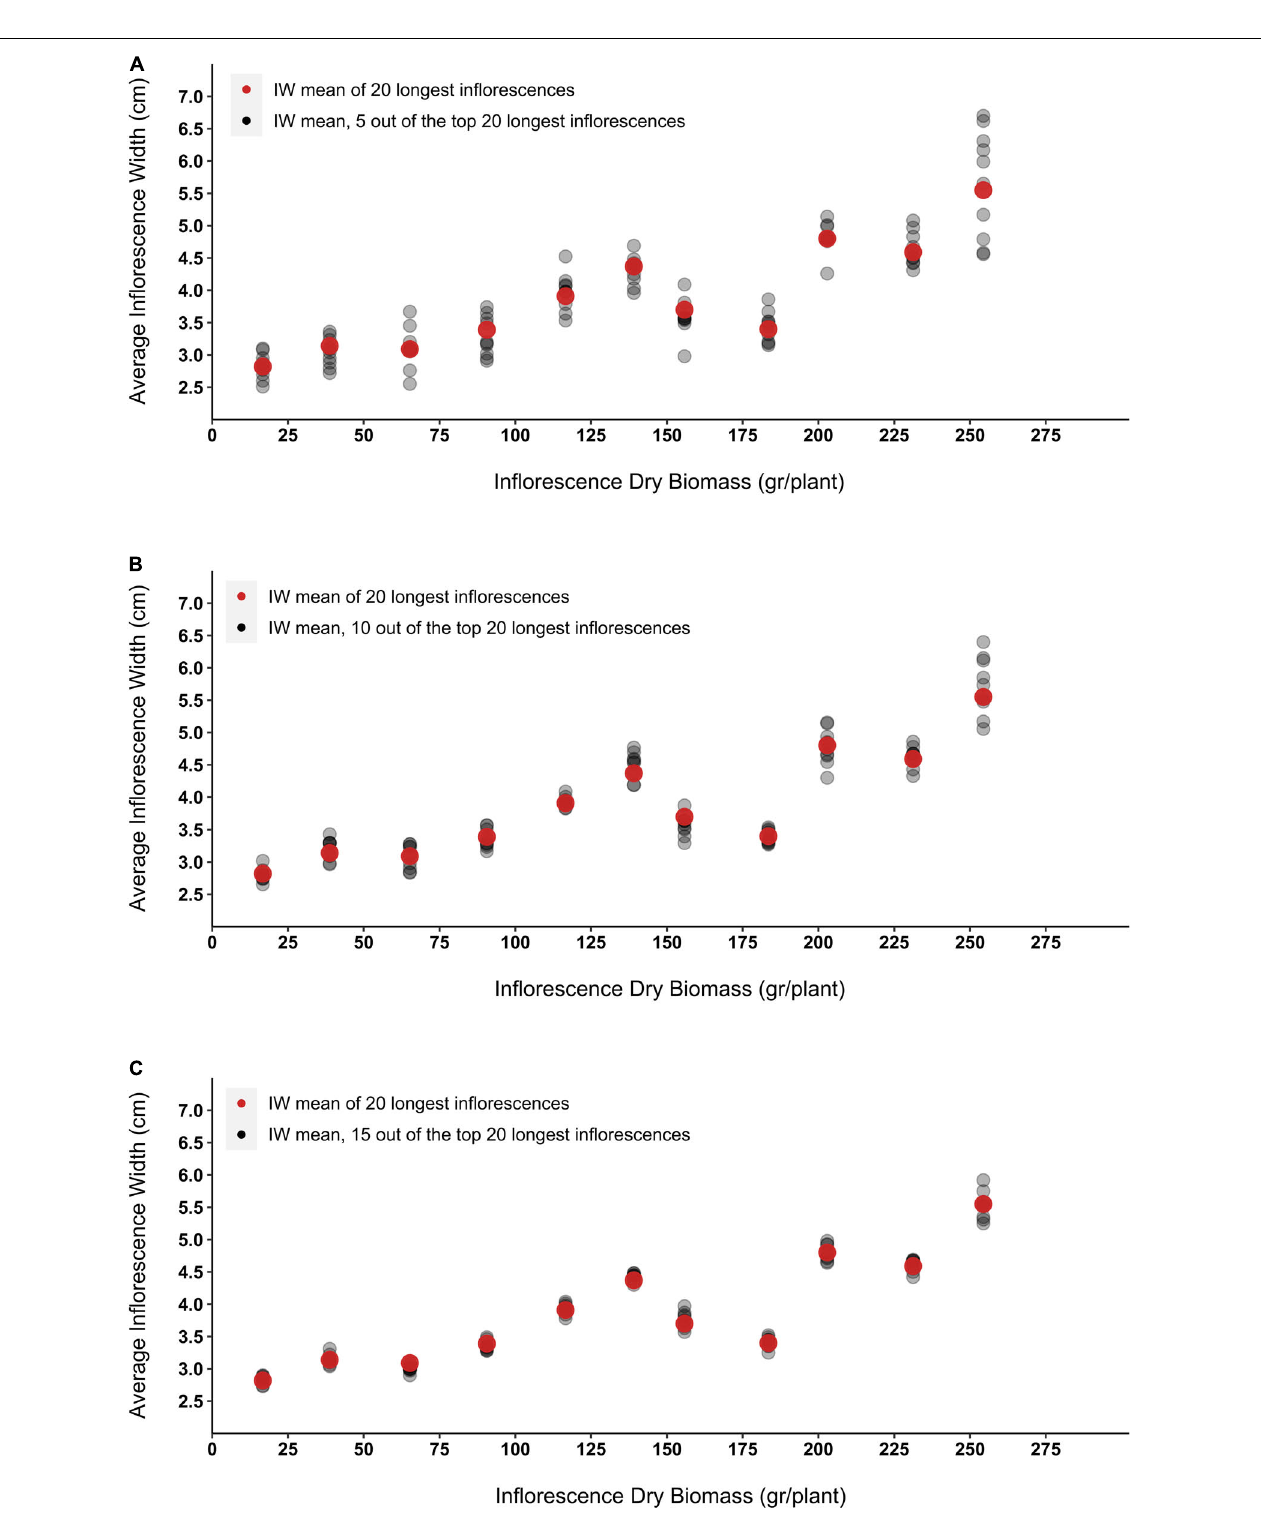
FIGURE 9 | The effect of inflorescence width (IW) measurement sample size on the accuracy of the obtained mean data. Red dots represent the mean of the entire sample group (the width of the top 20 longest inflorescences). Grey dots represent the inflorescence width average that was obtained from 10 sampling rounds of (A) 5 randomly selected inflorescences (out of the top 20 longest inflorescences), (B) 10 randomly selected inflorescences (out of the top 20 longest inflorescences), and (C) 15 randomly selected inflorescences (out of the top 20 longest inflorescences).